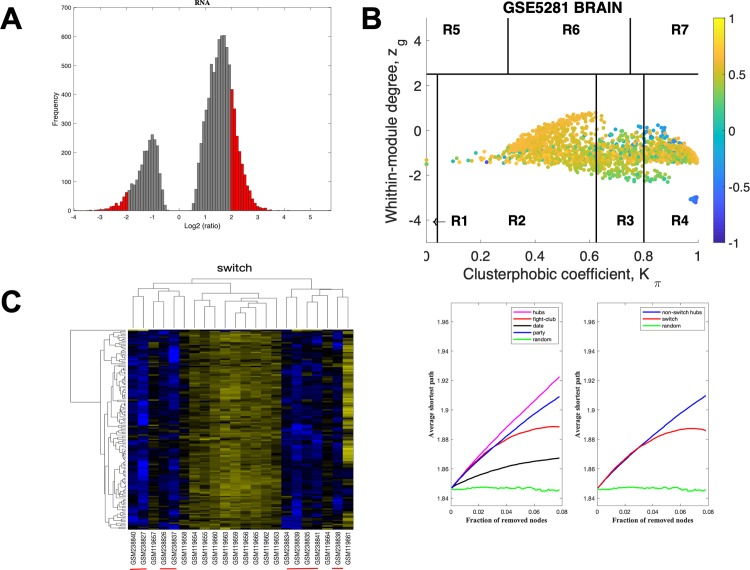
SWIM analysis of the posterior cingulate.A. Distribution of the fold-change values for GSE5281 brain microarray gene expression data from the PC. The x-axis represents the fold-change value (log2 of the fold-change) that is the ratio of the average expression data in AD patients compared to the average expression data in normal controls computed for protein-coding and non-coding RNAs. The y-axis represents the frequency of the obtained fold-change values. The grey bars represent the fold-change values associated with protein-coding and non-coding RNAs that will be discarded according to the selected threshold. The red bars represent the fold-change values associated with protein-coding and non-coding RNAs that were retained for further analysis. B. Heat cartography map for GSE5281 brain data from the PC. correlation network. The plane is identified by two parameters: Zg (within-module degree) and Kπ (clusterphobic coefficient) and it is divided into seven regions each defining a specific node role (R1-R7). High Zg values correspond to nodes that are hubs within their module (local hubs), whereas low Zg values correspond to nodes with few connections within their module (non-hubs within their communities, but they could be hubs in the network). Each node is colored according to its average Pearson Correlation coefficient (APCC) value. Yellow nodes are party and date hubs, which are positively correlated in expression with their interaction partners. Blue nodes are the fight-club hubs, which have an average negative correlation in expression with their interaction partners. Blue nodes falling in the region R4 are the switch genes, which are characterized by low Zg and by high Kπ values and are connected mainly outside their module. C. Dendrogram and heat map for switch genes in GSE5281 brain microarray gene expression data from the PC. The expression profiles of switch genes (including protein-coding and non-coding RNAs) are clustered according to rows (switch genes) and columns (samples) of the switch genes expression data (biclustering). The colors represent different expression levels that increase from blue to yellow. The red line under the x axis labels denotes AD samples. D. Robustness for the GSE5281 brain correlation network from the PC. The x-axis represents the cumulative fraction of removed nodes, while the y-axis represents the average shortest path. The shortest path between two nodes is the minimum number of consecutive edges connecting them. Each curve corresponds to the variation of the average shortest path of the correlation network as function of the removal of nodes specified by the colors of each curve.